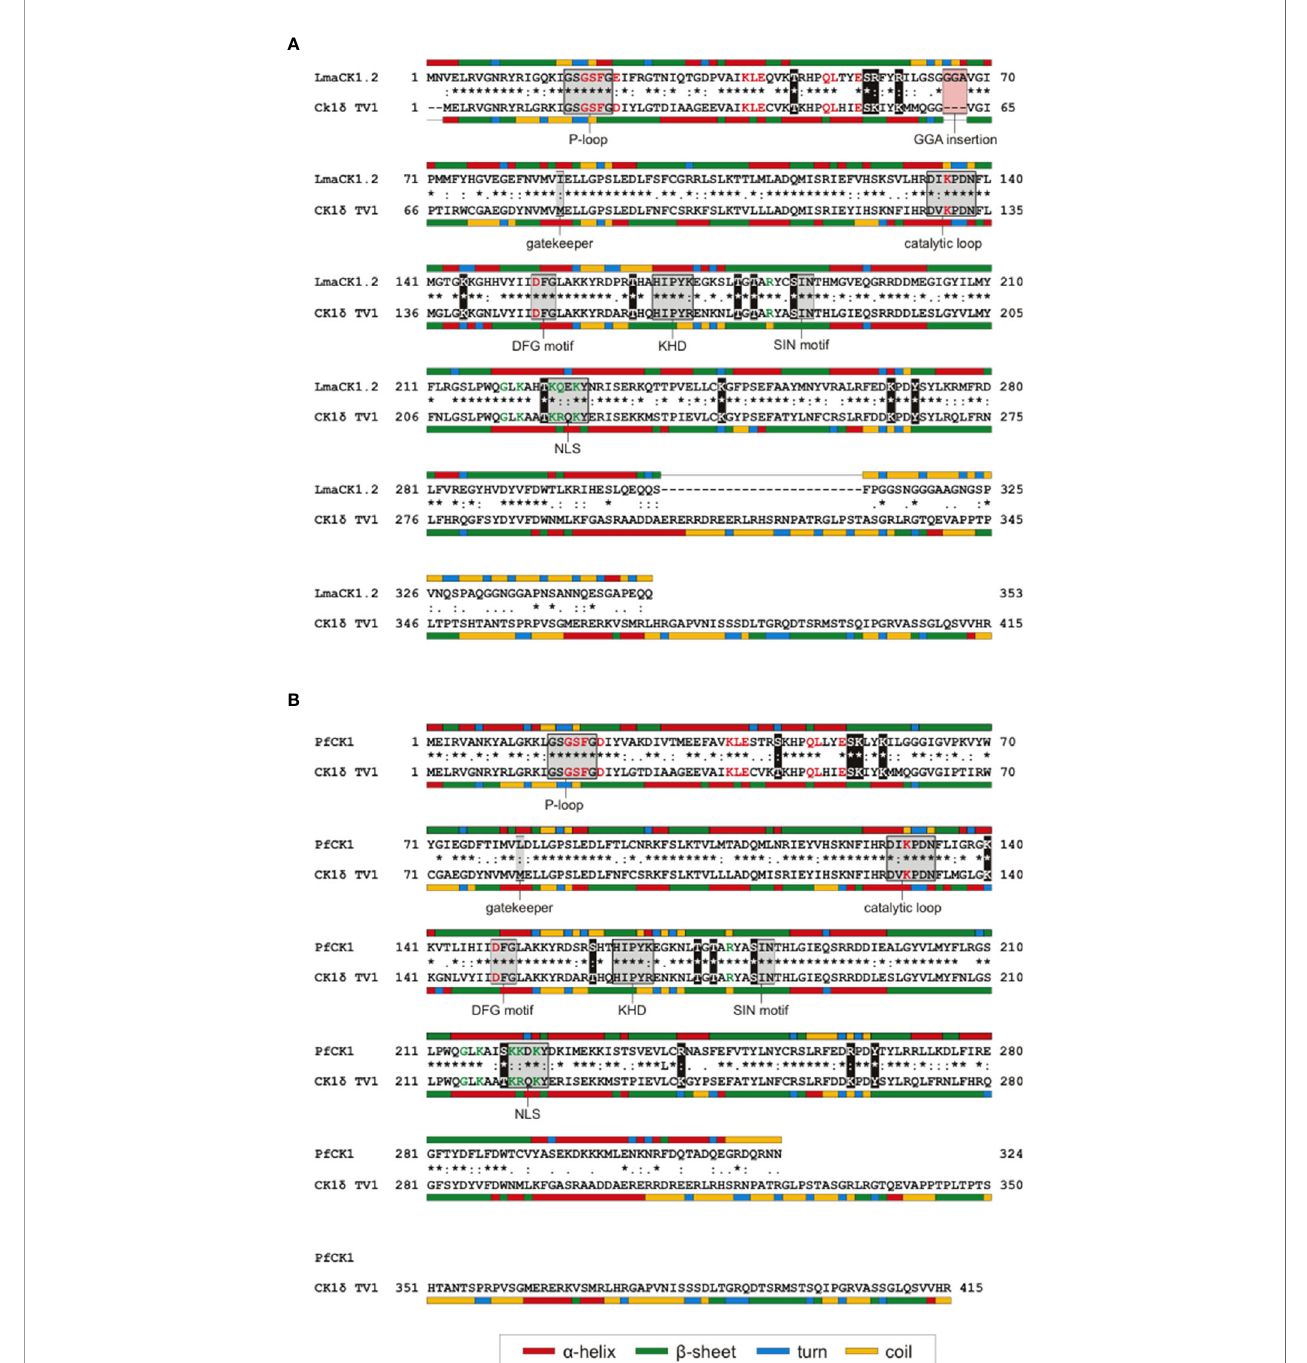
FIGURE 2 | Sequence alignment of LmaCK1.2 (A) and PfCK1 (B) with human CK1 d TV1. (A) Protein sequences of the major casein kinase 1 (CK1) isoform of Leishmania (LmaCK1.2) and human CK1 d TV1 were aligned using ClustalW (Thompson et al., 1994). Full conservation of amino acids (*), strong conservation (:) and weak conservation (.) is indicated in the line between the sequences. Secondary structure features were predicted using CFSSP (Ashok Kumar, 2013) and are indicated by a color code next to the respective sequence. Speci fi c motifs, residues involved in ATP-binding (red characters), as well as residues involved in substrate recognition (green characters) for human CK1 d are indicated in the fi gure as well as the alternative residue in LmaCK1.2, if different. (B) Protein sequences of PfCK1 of Leishmania (LmaCK1.2) and human CK1 d TV1 were aligned as described in (A)